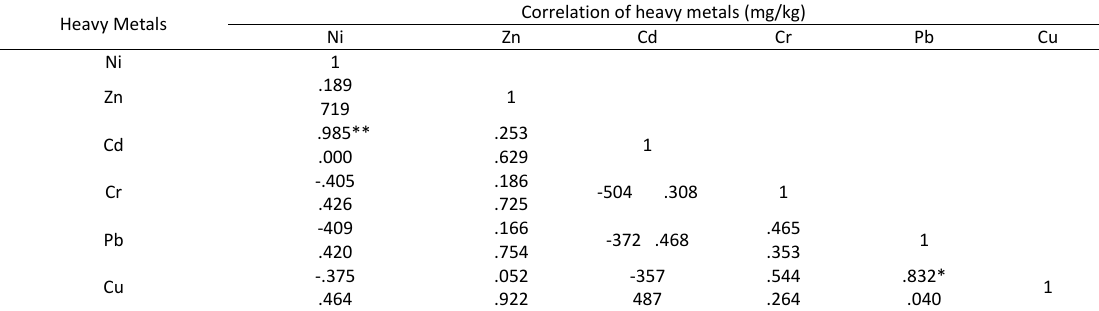
Table 5: Correlation between the selected heavy metals and farmland at 0 – 20 cm Depth